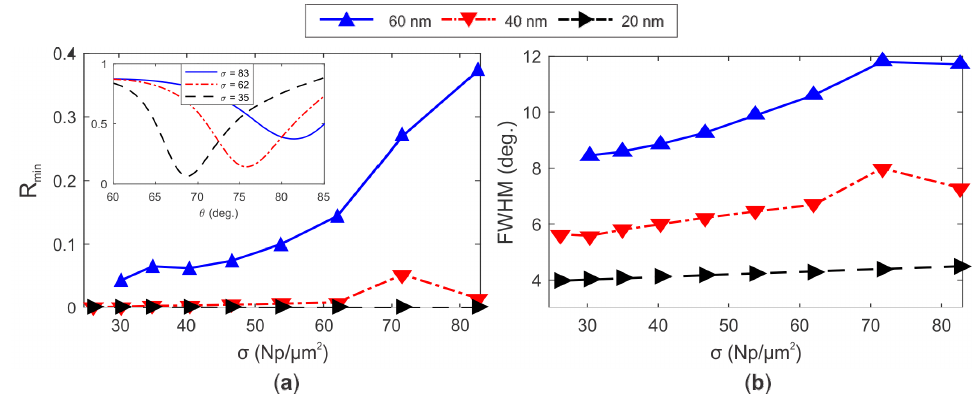
Figure 9. ( a ) Rmin and ( b ) FWHM of the reflectivity SPR spectra calculated by FEM for AuNPs with diameters of 60 nm, 40 nm, and 20 nm, and surface density in the range of 26 < σ < 83 Np/µm 2 . In ( a ), the inset highlights the reflectivity curves for 60 nm sized AuNPs and surface densities σ of 83, 62 and 35 Np/µm 2 .